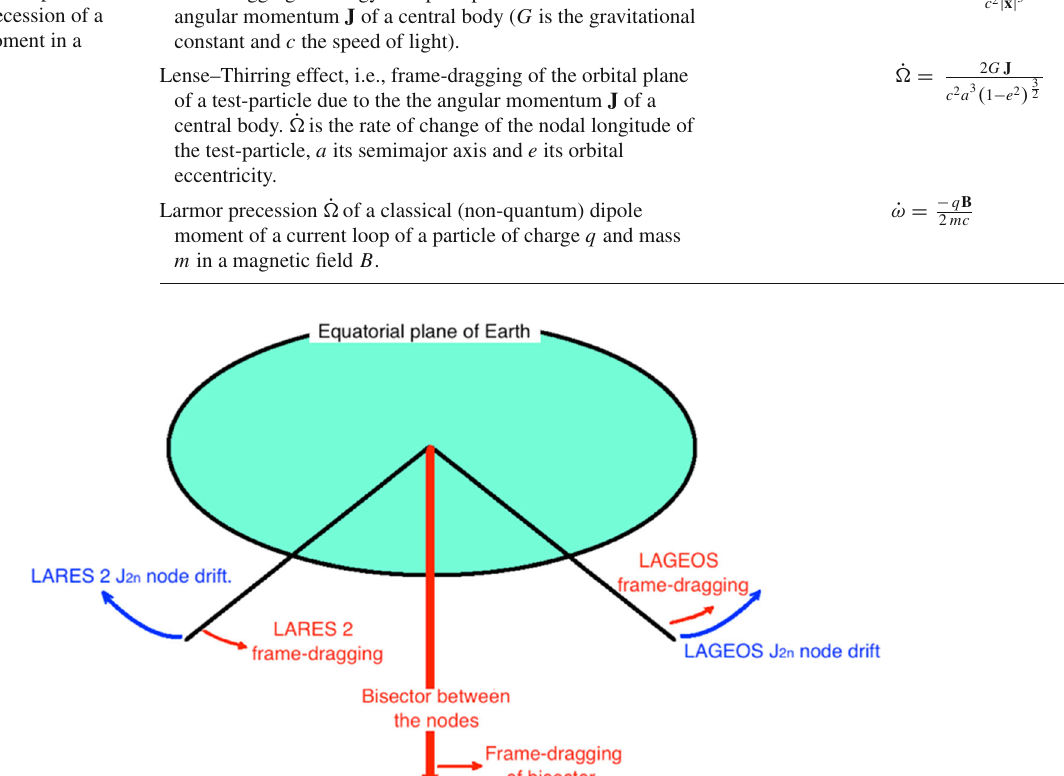
tude and sign, in the same sense of rotation of the Earth, independently of their inclination. Thus, the bisector of the nodal lines of LARES 2 and LAGEOS is not affected by the Earth’s even zonal harmonics and has only a secular drift due to frame-dragging [5], as if it were a huge gyroscope in the gravitational field of a spherically symmetric